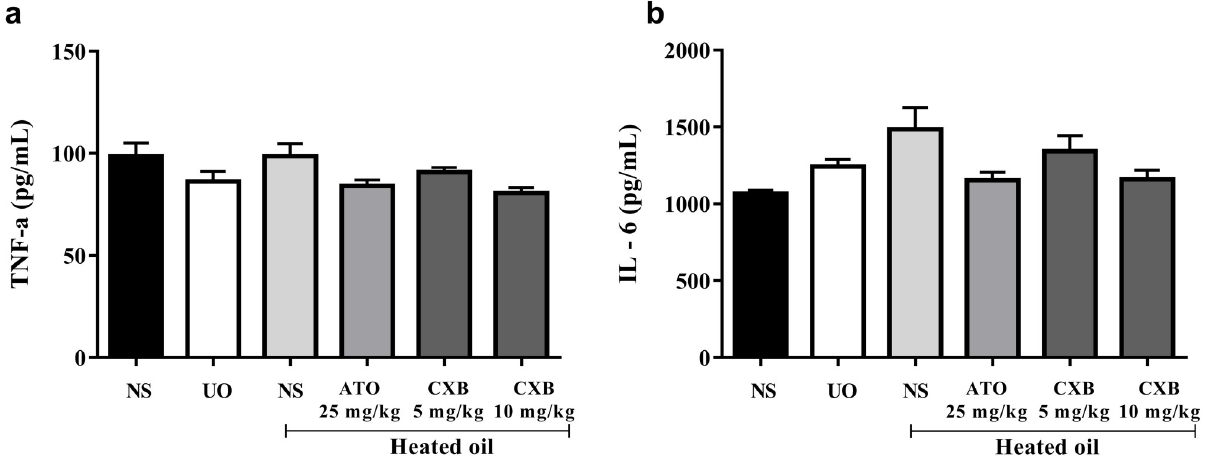
Fig 6. Effect of celecoxib (CXB 5 and 10 mg/kg) and atorvastatin (ATO 25 mg/kg) on the levels of serum cytokines such as (a) TNF- α and (b) IL-6 in overheated-oil induced hyperlipidaemia in Sprague-Dawley rats. Values are expressed as mean ± SEM (n = 6). There were no significant differences between heated oil and other treatment groups (all were compared using one-way ANOVA followed by Newman-Keuls’ post hoc test).